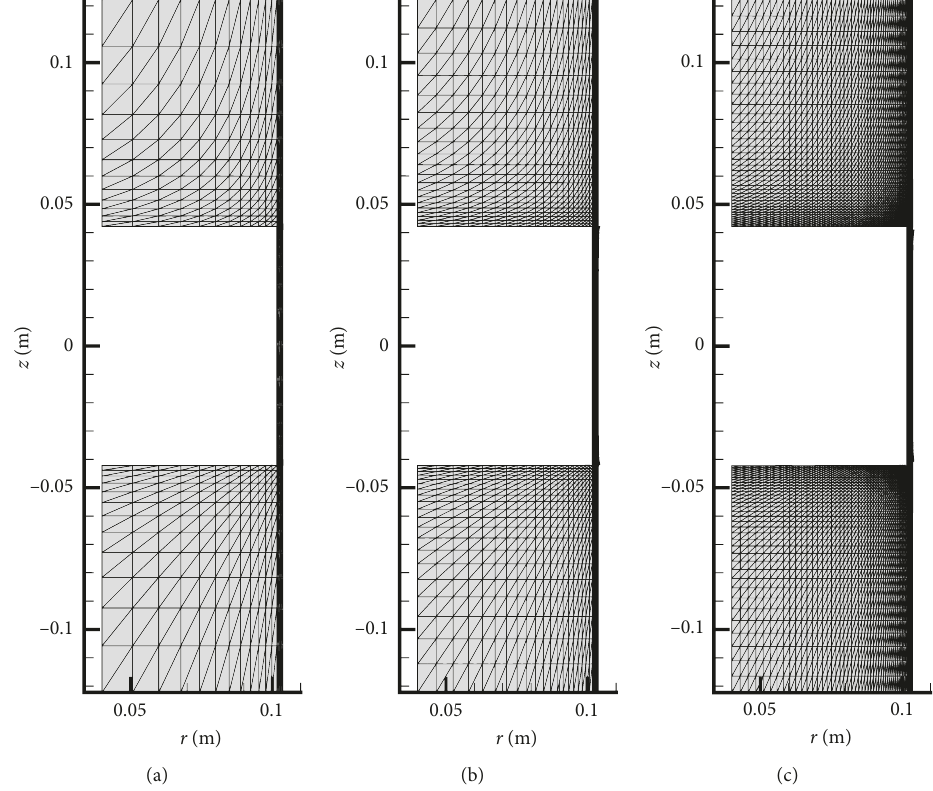
Figure 8: FEM meshes with different refinement levels. (a) Coarse mesh (13656 DOFs). (b) Normal mesh (50698 DOFs). (c) Fine mesh (127018 DOFs).